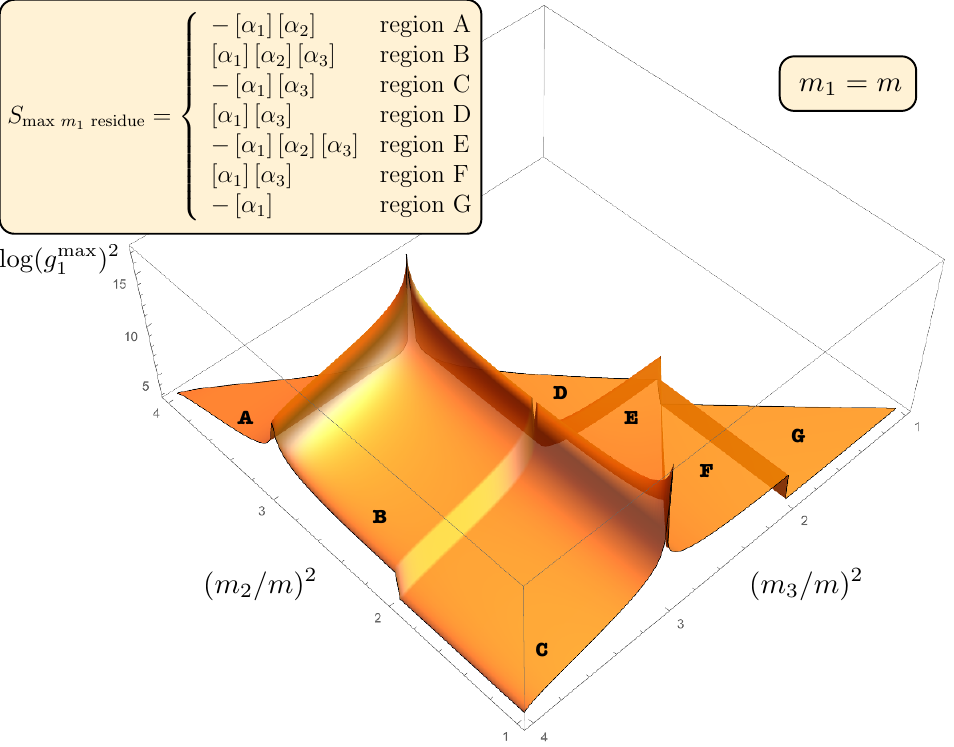
Figure 11 . Maximal coupling g max ( m 2 =m; m 3 =m ) for the spectrum m 1 = m (i.e. a cubic coupling 1 m + m m ) and generic m < m 2 < m 3 < 2 m !